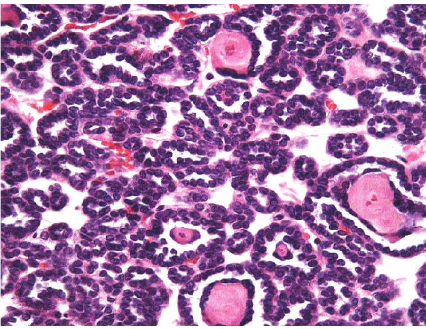
Figure 5: Metanephric adenoma. microacinar structures of basophilic cells with a nephroblastic